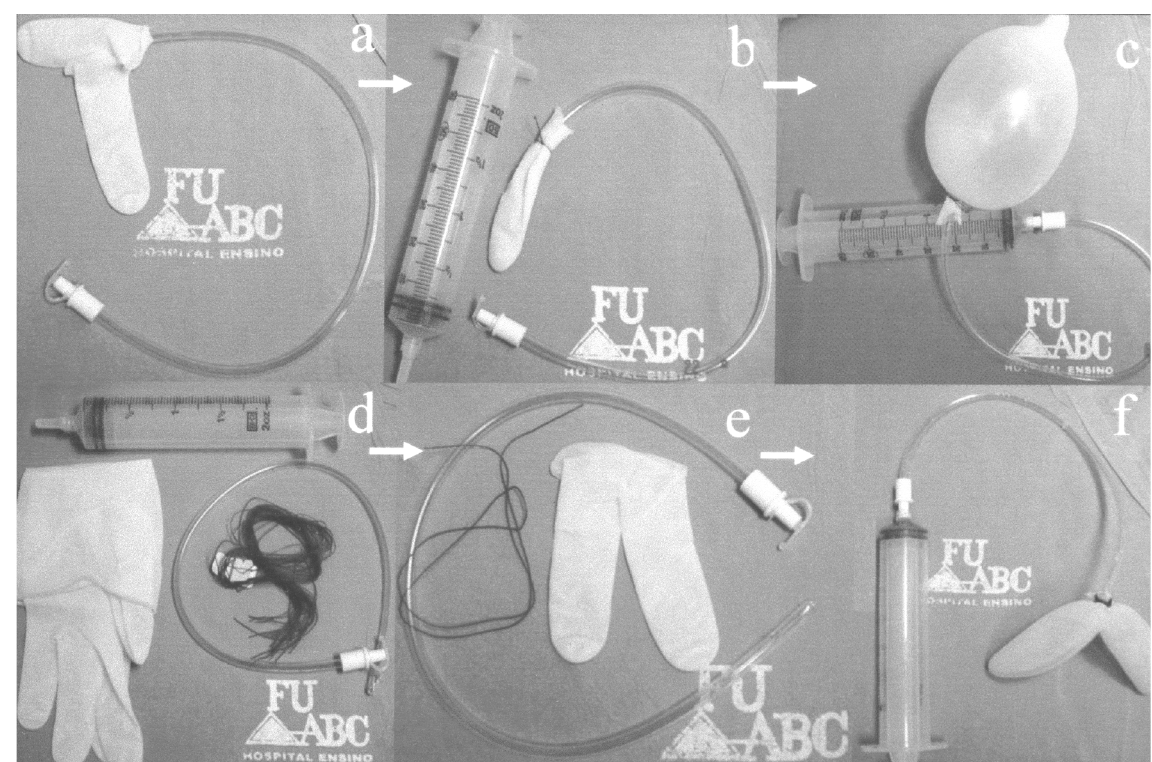
Figure 3 – Homemade dilating balloon with single (a,b,c) and double (d,e,f) glove